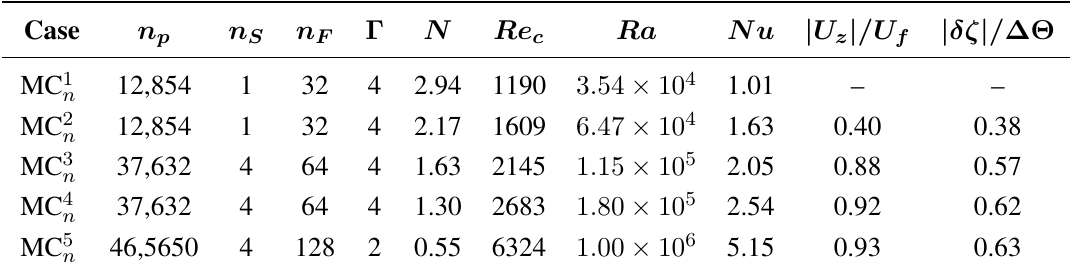
Table 6. SFEMaNS-T magnetoconvection (MC) simulation parameters. The Chandrasekhar, Prandtl and magnetic Prandtl numbers have fixed values of Q = 3 . 5 × 10 3 , P r = 0 . 025 and P m = 10 − 4 ,